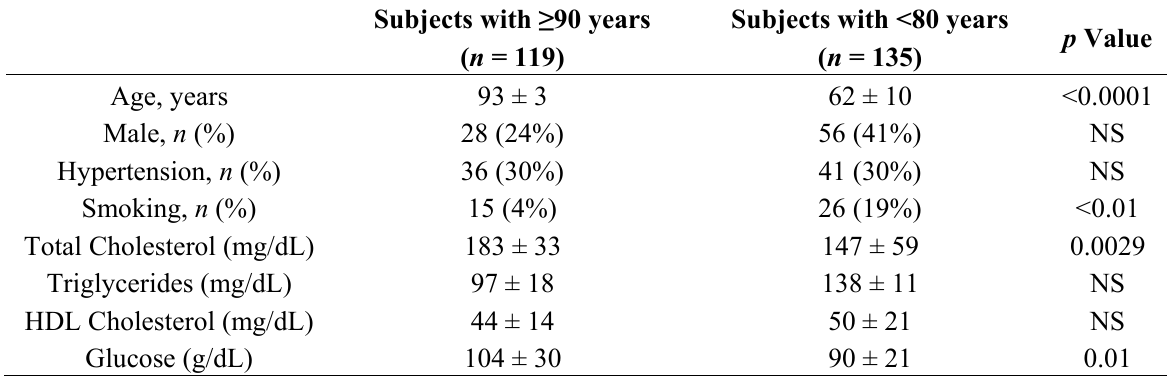
Table 1. Demographic, clinical and biochemical characteristics of subject included in the study.